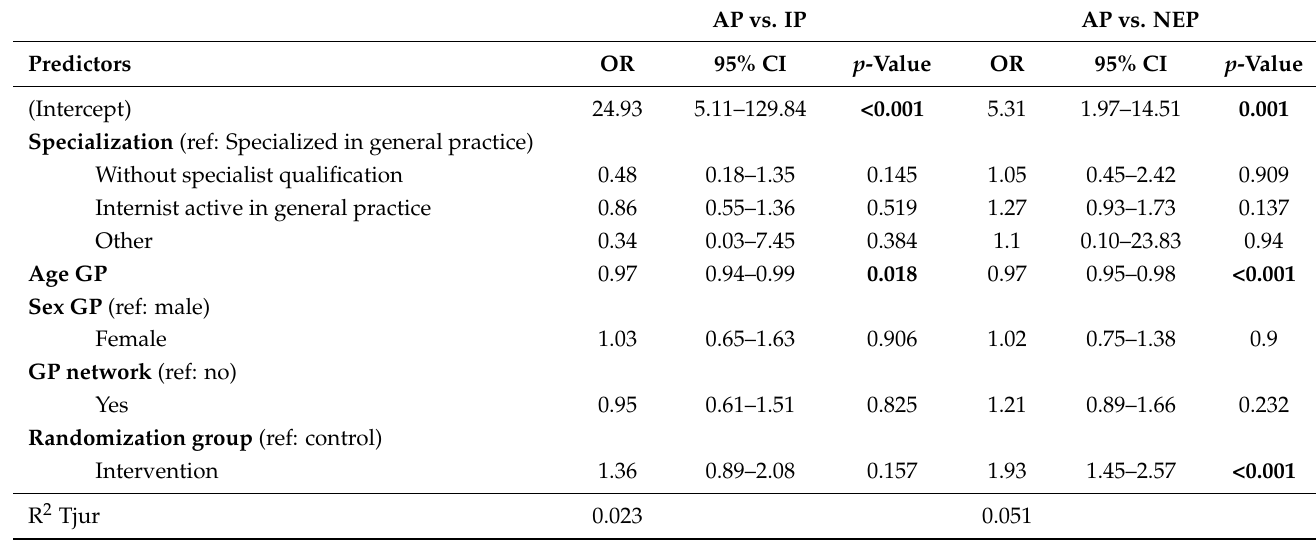
Table 2. Factors related to the chance of belonging to AP versus IP and AP versus NEP GPs.